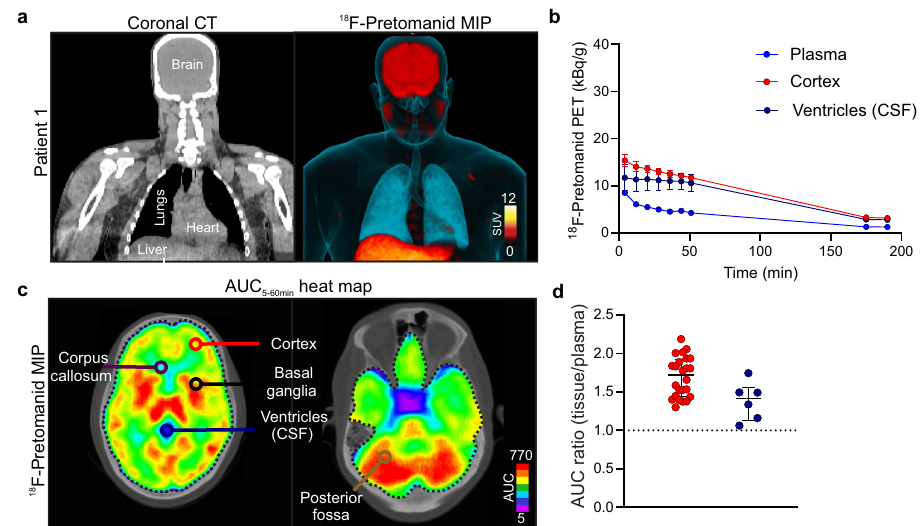
d AUC 4-55min (tissue/plasma)ratiosfromthecortexandCSF(ventricles)( P =0.018). PET studies are based on microdoses (ng- µ g) administered intravenously from six human subjects. SUV, standard uptake values. Data are represented as median± IQR. Statistical comparisons were performed using 2-way ANOVA followed by Bonferroni ’ s multiple-comparison test. Source data are provided as a Source Data fi